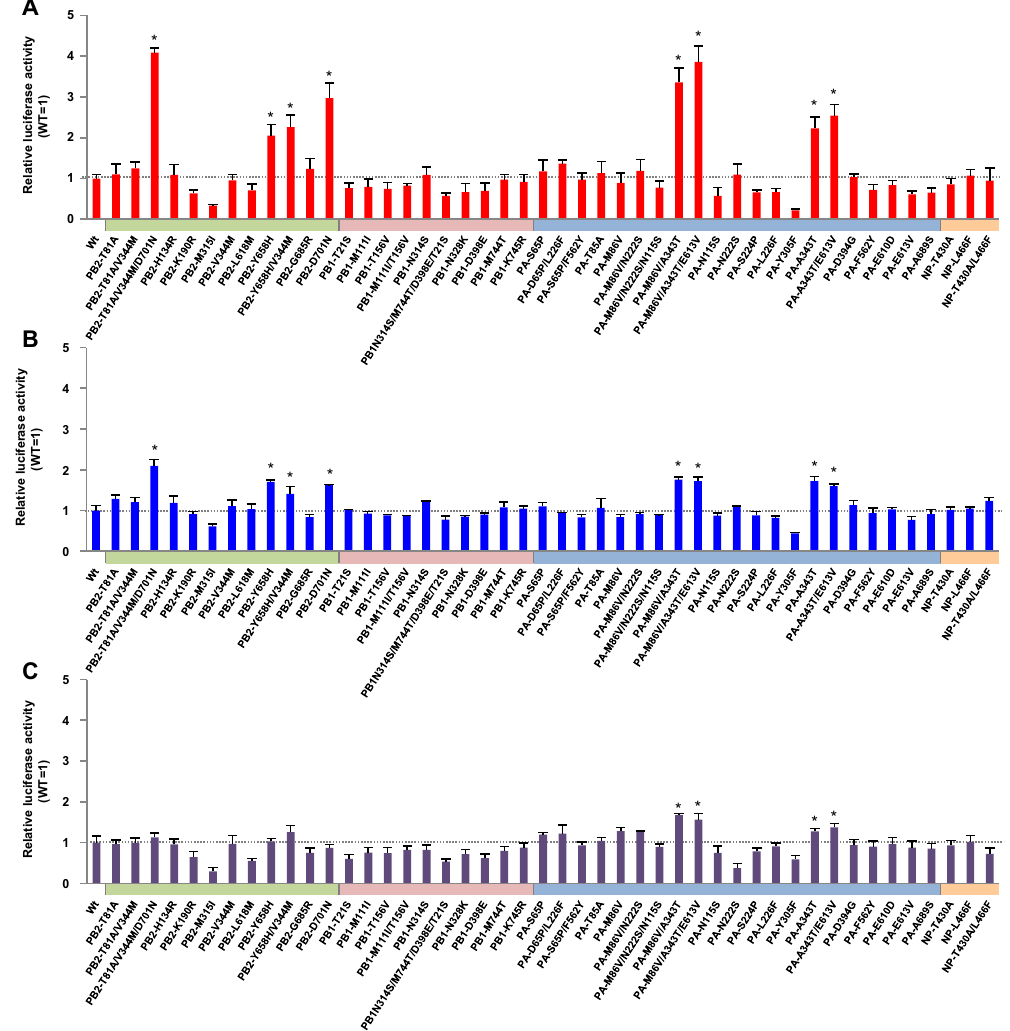
Figure 1. Effect of mutations on H5N1 clade 2.3.4 virus polymerase activity. Human 293T cells and avian DF-1 cells were transfected with plasmids expressing VN/HN PB2, PB1, PA or NP with the indicated single or multiple mutations, a human or chicken polymerase I-driven plasmid expressing a vRNA-oriented luciferase reporter gene, and a plasmid expressing Renilla luciferase as an internal control. After 48 h incubation at 33 or 37 °C, luciferase activities were measured, normalized to the internal Renilla luciferase activity, and expressed relative to the results for VN/HN (wt). ( A ) VN/HN polymerase activity at 37 °C in 293T cells. ( B ) VN/HN polymerase activity at 33 °C in 293T cells. ( C ) VN/HN polymerase activity at 37 °C in DF-1 cells. Colors on each x-axis indicate the different virus genes. An asterisk indicates a P value < 0.01 (ANOVA with Tukey’s multiple comparison test). Asterisks for mutations with negative effects on polymerase activity were omitted for